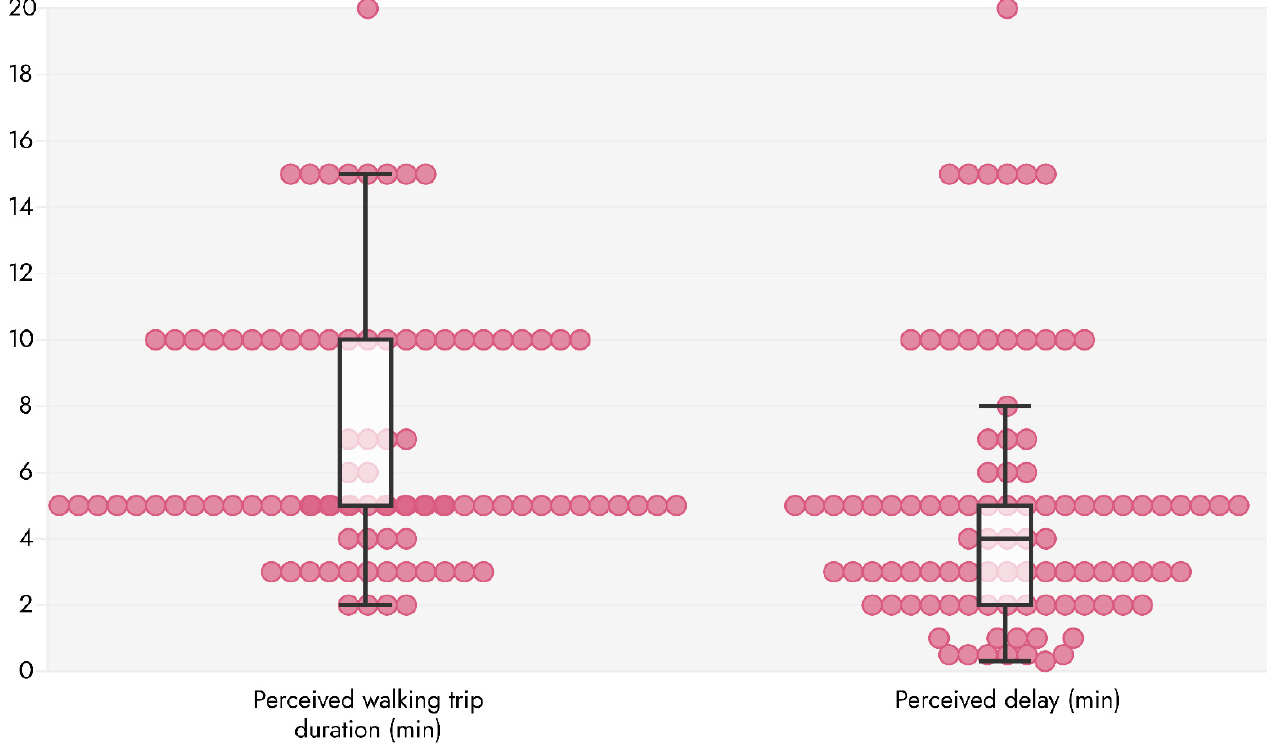
Figure 8. Beeswarm plot of the two examined variables.